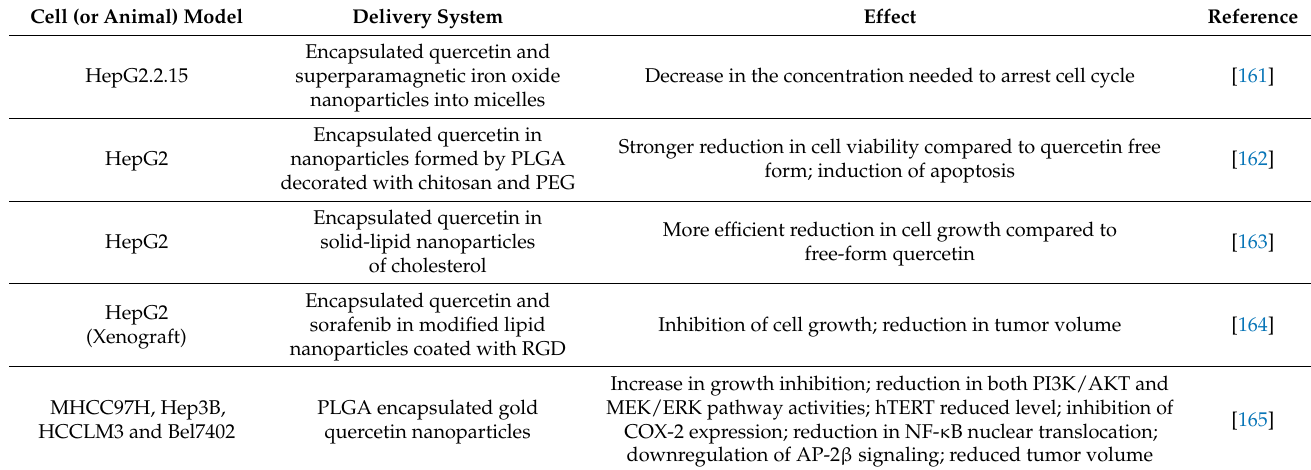
Table 9. Targets affected by quercetin in different delivery systems in HCC experimental